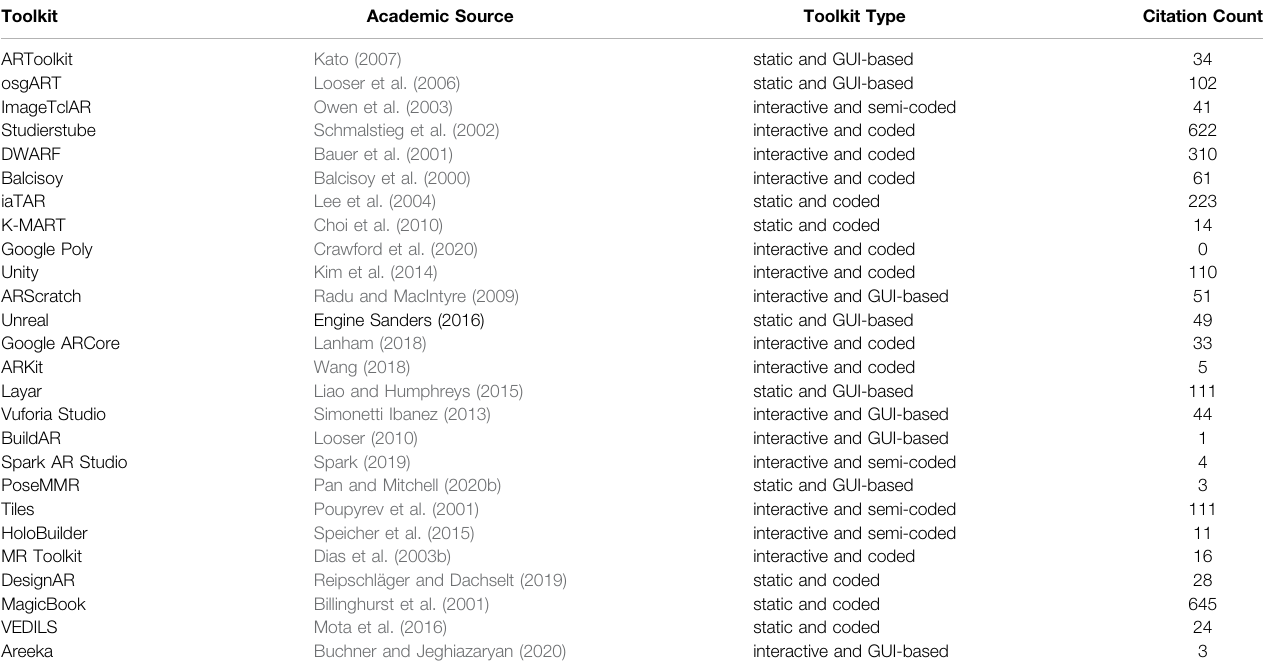
TABLE 3 | Academic references to AR Authoring Toolkits, Toolkit Types and citations.